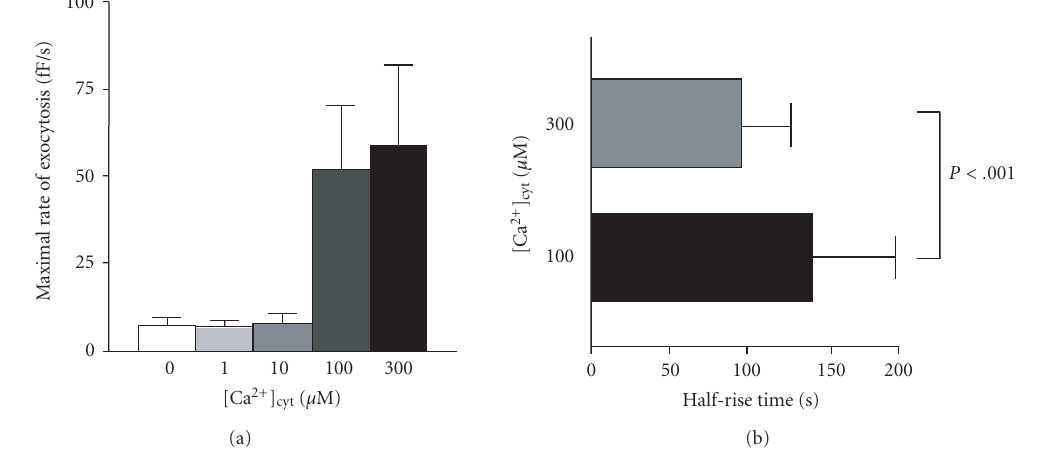
Figure 2: Dynamics of secretion at di ff erent [Ca 2+ ] i . (a) Maximal rates of capacitance increase during neutrophil exocytosis. The capaci- tance values were recorded during a 5–10 min period after breakthrough with the patch pipettes, and the maximal rate of exocytosis was determined from each capacitance trace. (b) Higher [Ca 2+ ] i gives shorter half-rise time. The time required for reaching half of the maximal capacitance increase is induced by 100 µ M and 300 µ M [Ca 2+ ] i , respectively.